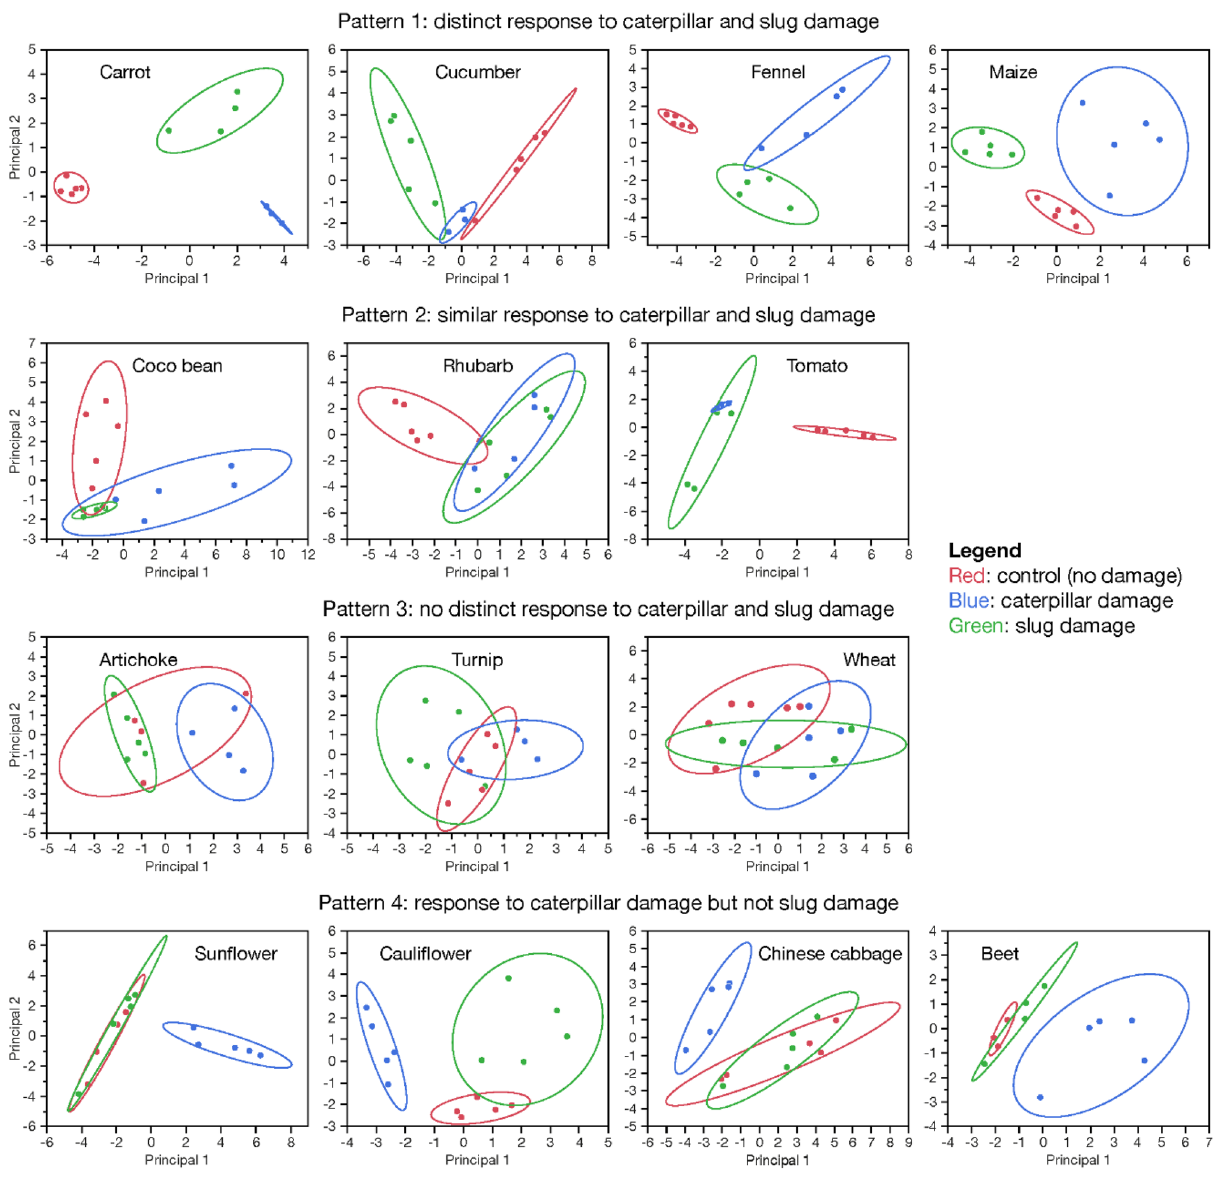
Figure 1. Principal components analyses of all plant species showing the four patterns of VOCs emissions observed for control (undamaged) plants, caterpillar-damaged plants, and slug-damaged plants. Pattern 1: distinct response to caterpillar and slug damage. Pattern 2: similar response to caterpillar and slug damage. Pattern 3: no response pattern to caterpillar or slug damage. Pattern 4: Response to caterpillar damage but not to slug damage. For each graph, the horizontal and vertical axes show projections on to the first and second principal components, respectively. Each dot represents a sample (= 1 plant) JMP®